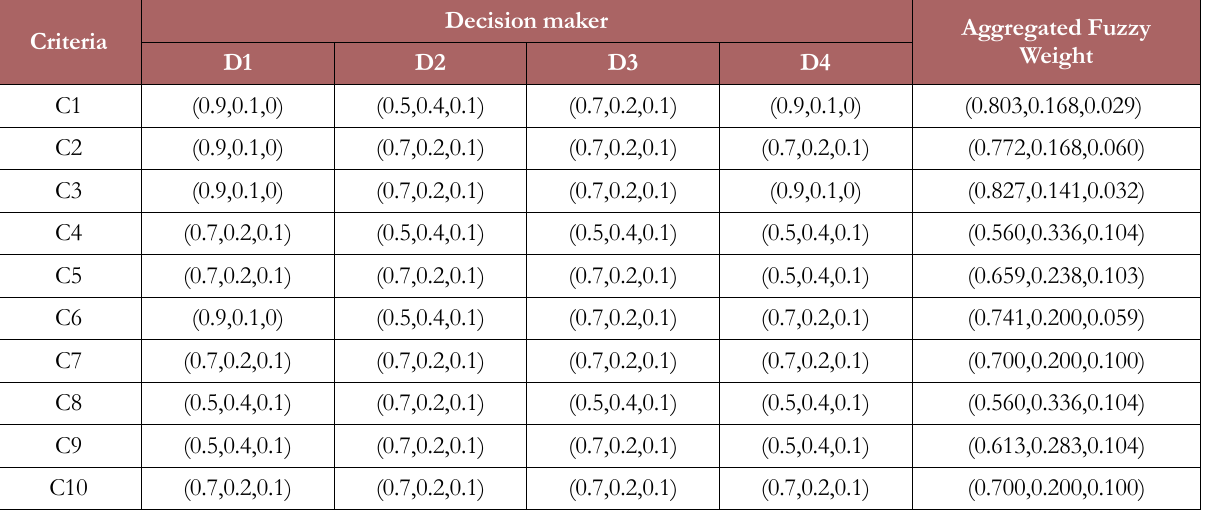
Table 16. Aggregate fuzzy weights for criteria